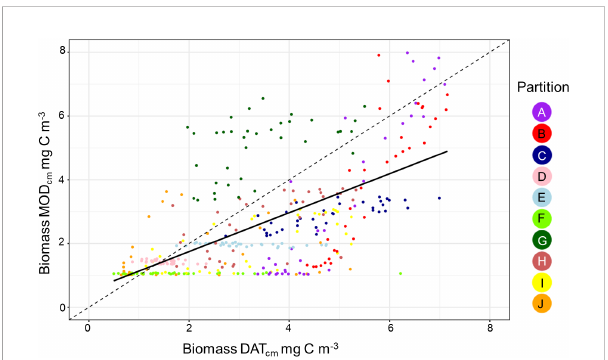
FIGURE 4 A scatterplot showing the relationship between the in situ data and model biomass. Each point shows the pairwise comparison between data and model for each of the 36 10 day periods within the 10 zooplankton